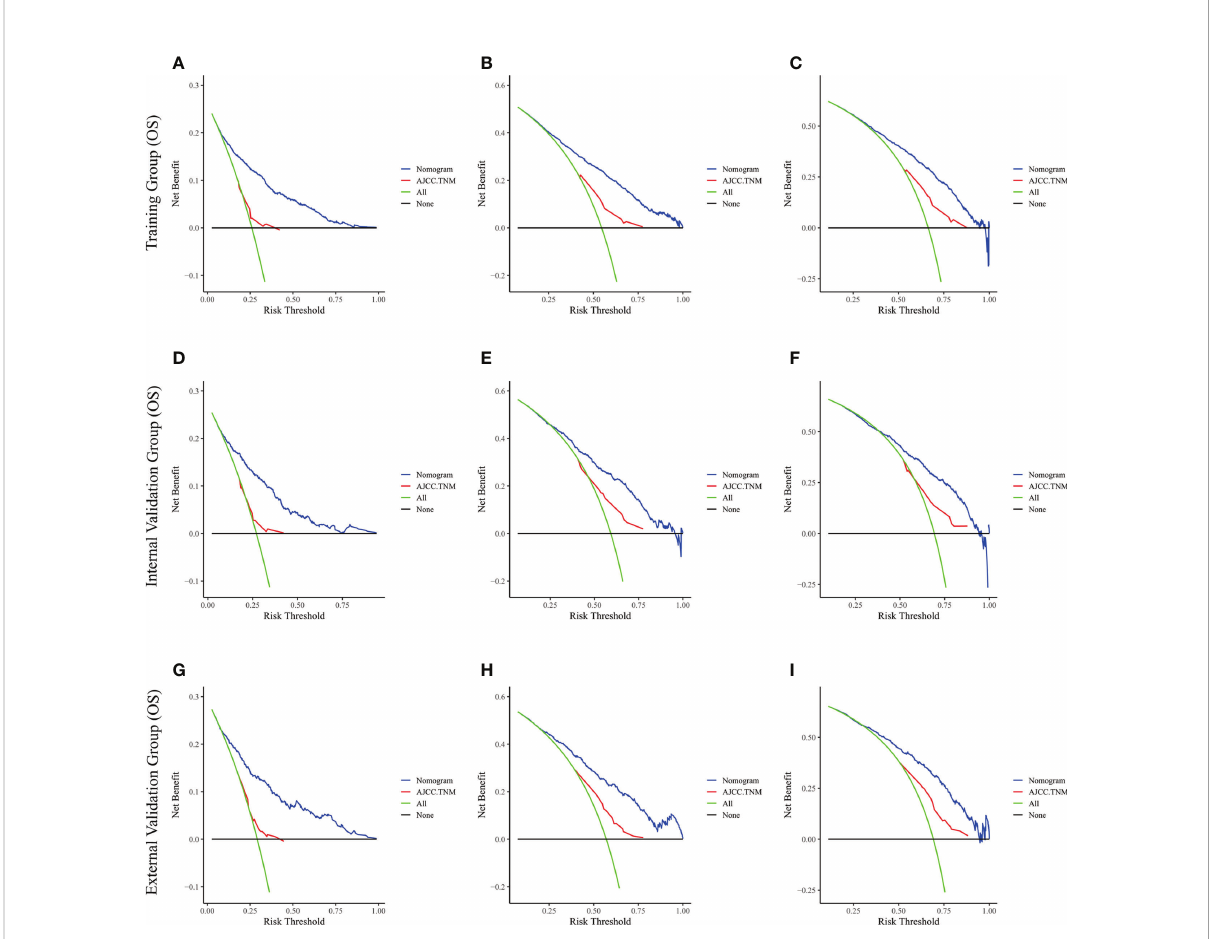
FIGURE 6 The decision curve analysis of the nomogram and AJCC.TNM for OS at (A) 1-year and (B) 3-year and (C) 5-year in the training cohort, and at (D) 1-year (E) 3-year and (F) 5-year in the internal validation cohort, and at (G) 1-year (H) 3-year and (I) 5-year in the external validation